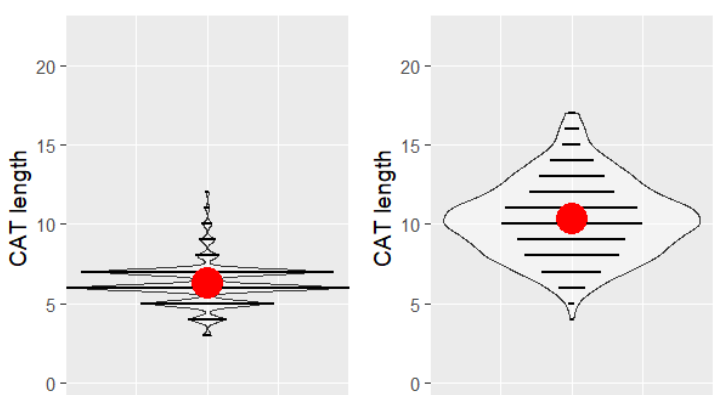
Figure 7. Test length comparison for the two fixed-precision CD-CAT implementations. The red dot represents the mean CAT length. GDI: general discrimination index; prog2: progressive method for item exposure control with b = 2.